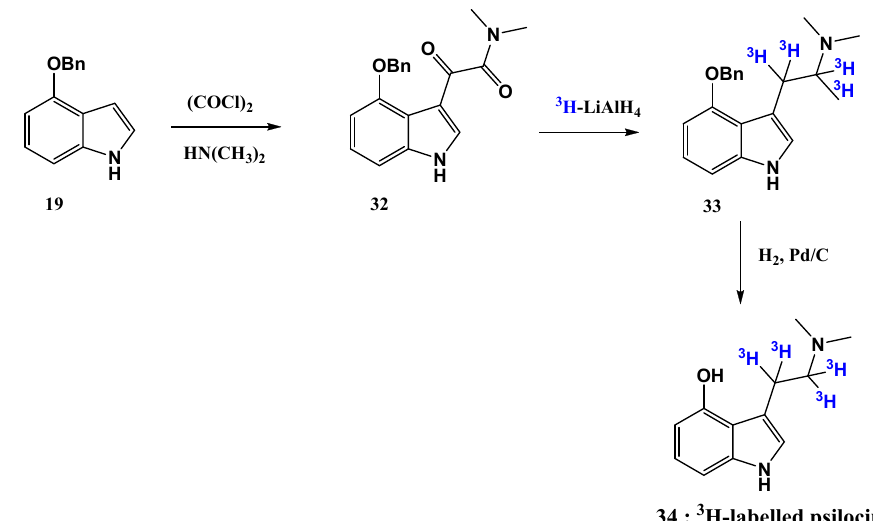
Scheme 12. 3 H-labeled psilocin synthesis by Poon et al. [49].